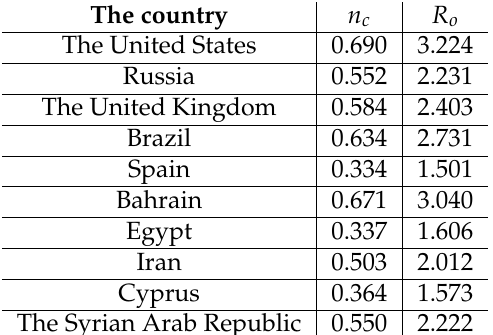
Table 3. The values of the critical immunization threshold and the basic reproduction number of SARS-CoV-2 in the United States, Russia, the United Kingdom, Brazil, Spain, Bahrain, Egypt, Iran, Cyprus and the Syrian Arab Republic. The